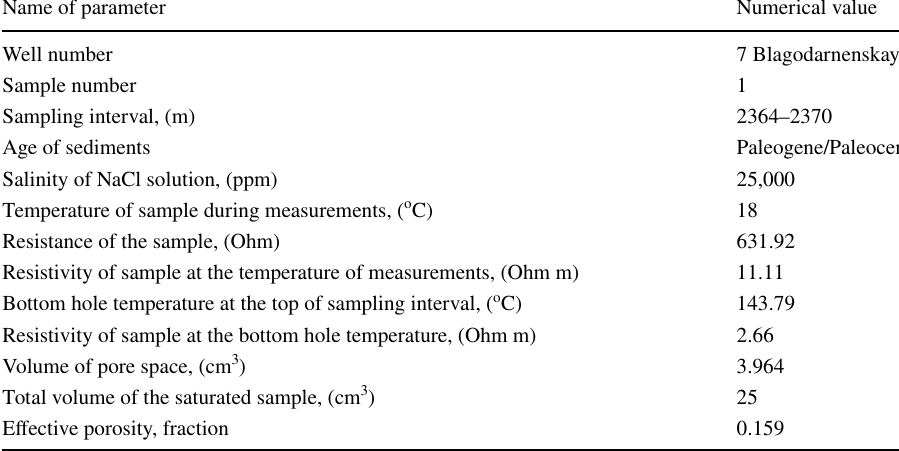
Table 5 The results of the core sample analysis from Well # 7